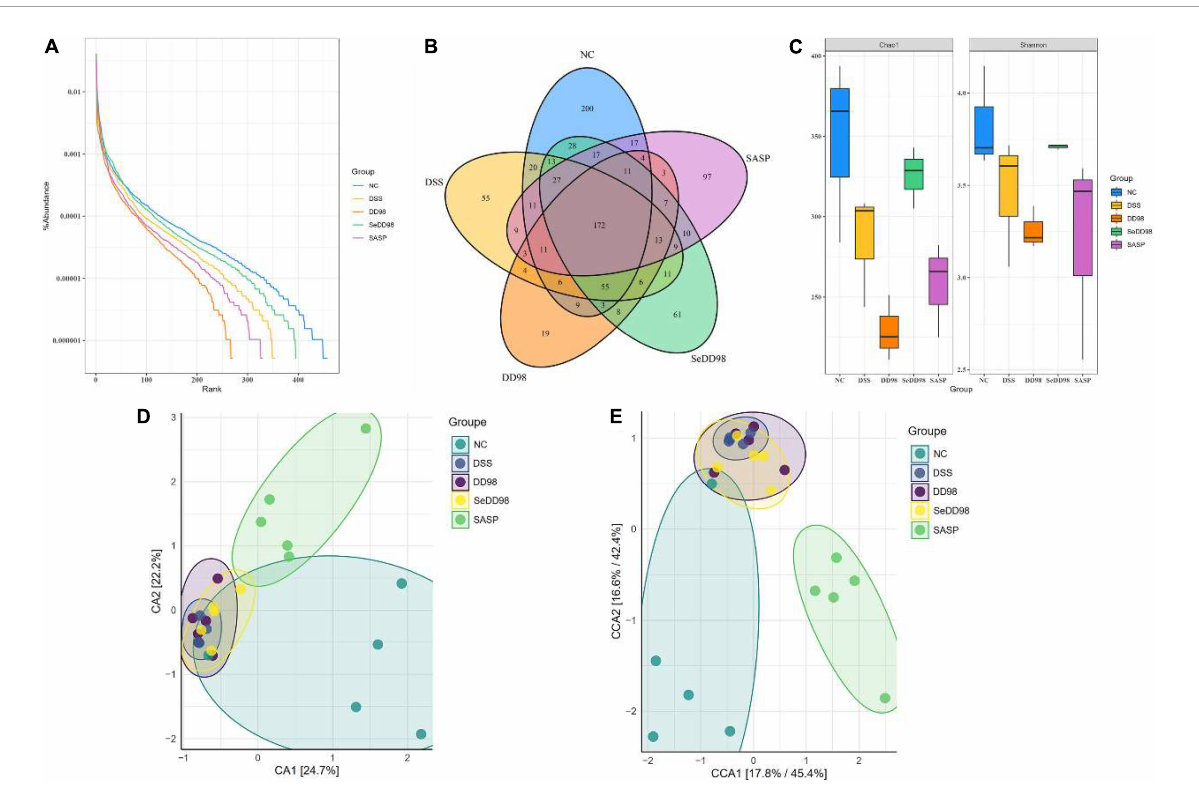
FIGURE6 The effect of Se- B. longum DD98 on the intestinal microbiota ( n = 3–5). (A) Rank-abundance curve. (B) Venn diagram. Totally 172 gut microbial species were shared by the five groups of mice, and there were 200, 55, 19, 61, and 97 distinct microbes (ASVs) in the NC, DSS, DD98, SeDD98, and SASP groups, respectively. (C) Chao and Shannon index. (D,E) CA and CCA analysis.